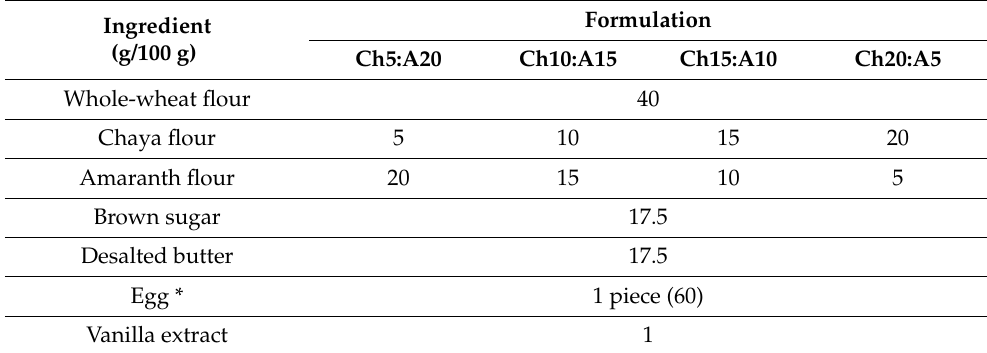
Table 6. Formulation of functional cookies with different concentrations of chaya and amaranth flours (g/100